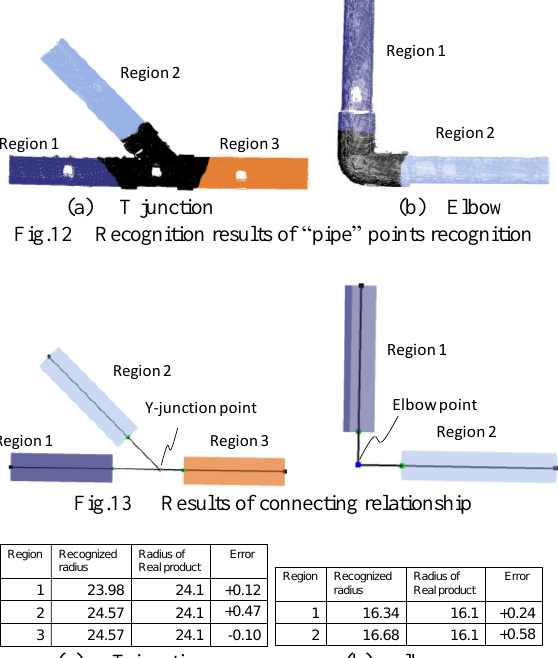
Table.1 Results of radius of pipe recognition